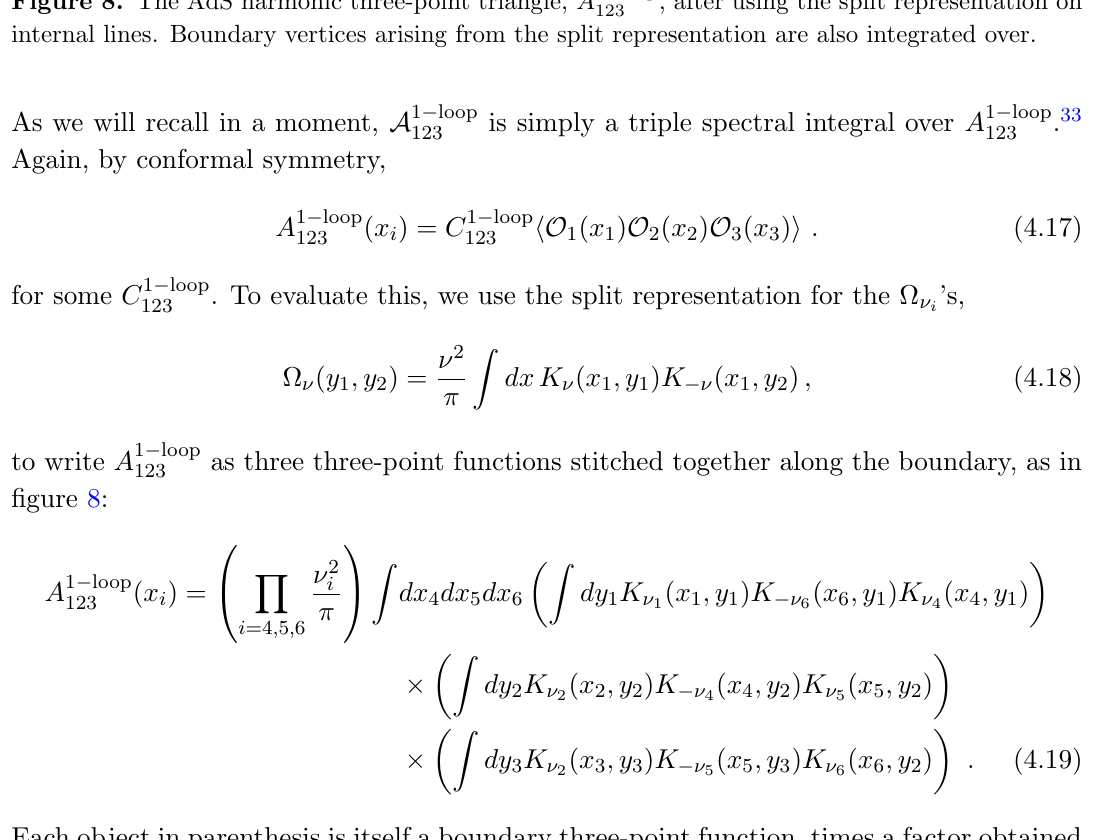
, after using the split representation on 123